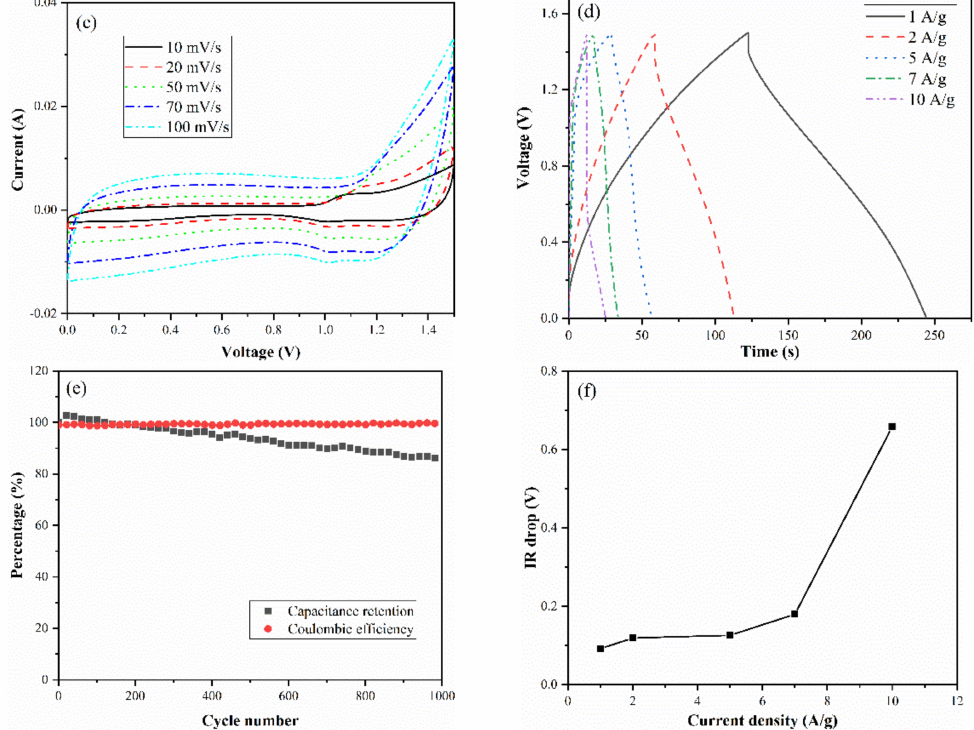
Figure 10. ( a ) Scheme of the hybrid supercapacitor (NiCo 2 S 4 /rGO//activated carbon); ( b ) CV measurements of NiCo 2 S 4 /rGO and activated carbon electrodes at a scan rate of 5 mV s − 1 in a three-electrode system; ( c ) CV curves of NiCo 2 S 4 /rGO//activated carbon HSC device at different scan rates; ( d ) initial GCD curves of NiCo 2 S 4 /rGO//activated carbon HSC device at different current densities; ( e ) the cycle stability and coulombic efficiency of NiCo 2 S 4 /rGO//activated carbon HSC device at a current density of 1 A g − 1 ; ( f ) IR drop of HSC device under different current densities.